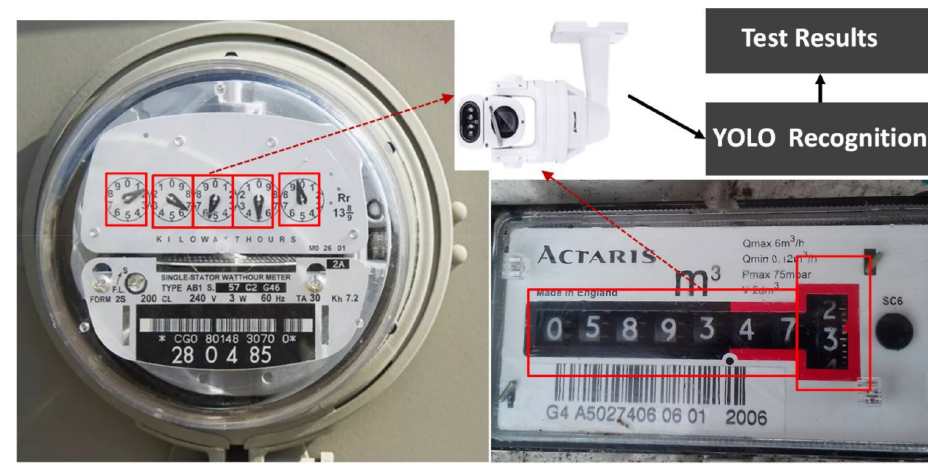
Figure 24. Visual-tests for analog